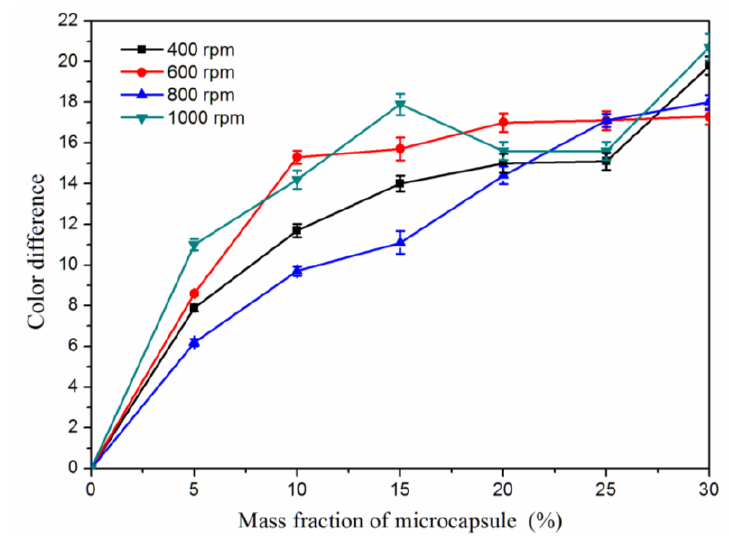
Figure 8. Influence of microcapsule mass fraction at different stirring rates on the color difference of paint film.